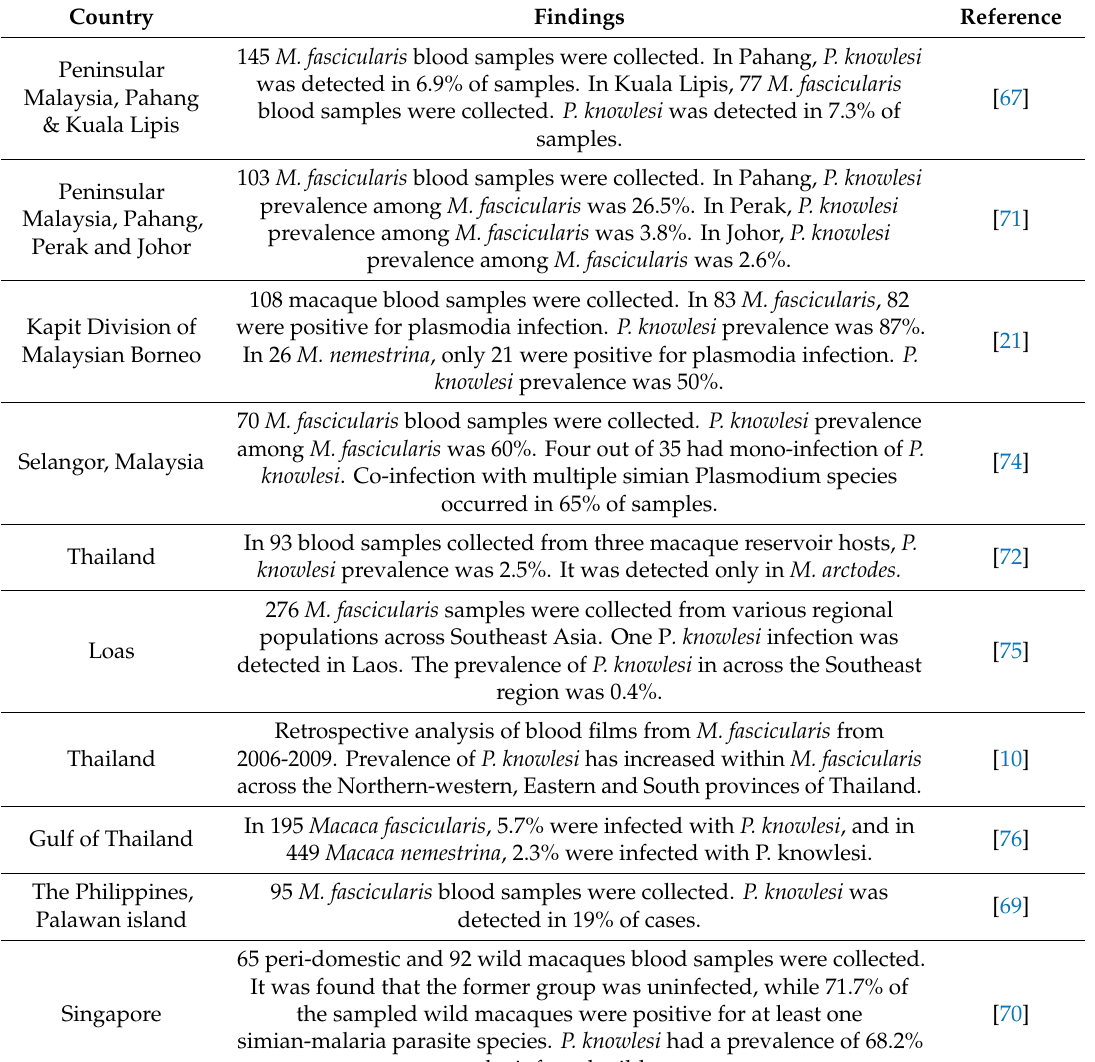
Table 2. Prevalence and Geographical Occurrence of Plasmodium knowlesi Infection in Macaque Host